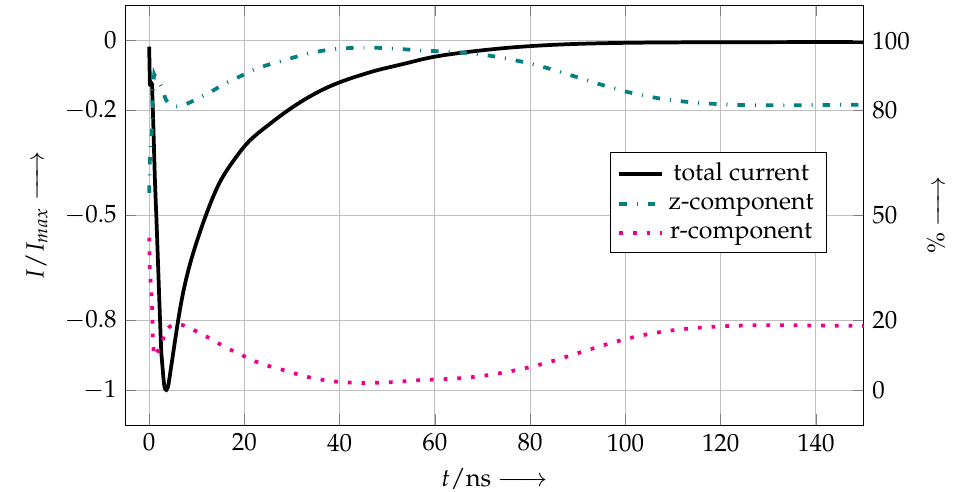
Figure 7. Simulated discharge current and proportions of the space components.